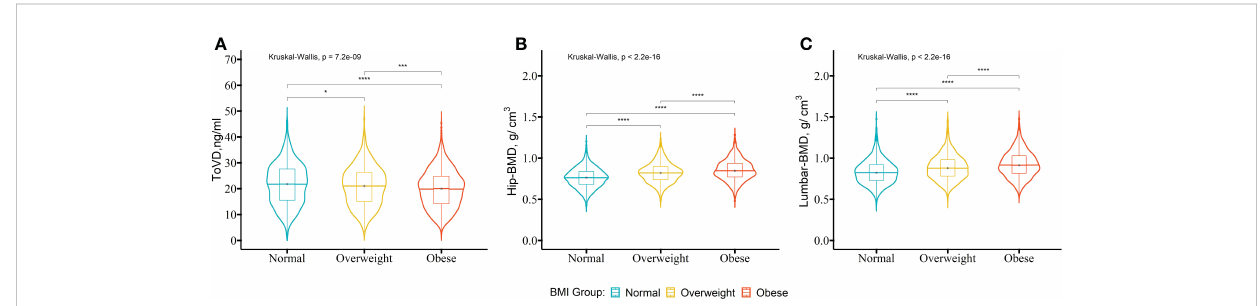
FIGURE 1 The levels of ToVD, Hip-BMD and Lumbar-BMD of the participants with different BMI groups. A comparison of the distributions of the biochemical parameters between the BMI groups was performed using the Kruskal-Wallis test. The post-hoc test was used in order to examine the differences between the pairs of the BMI groups with the Bonferroni ’ s method. The participants were divided into three groups based on BMI including the normal group (18.5-22.9 kg/m 2 ), overweight group (22.9-24.9 kg/m 2 ) and obese group (>25.0 kg/m 2 ).The box represents the median and interquartile ranges. BMI, body mass index; ToVD, total 25(OH)D; Hip-BMD, hip bone mineral density; Lumbar-BMD, lumbar bone mineral density. ****p < 0.0001; ***p < 0.001; **p < 0.01; *p <